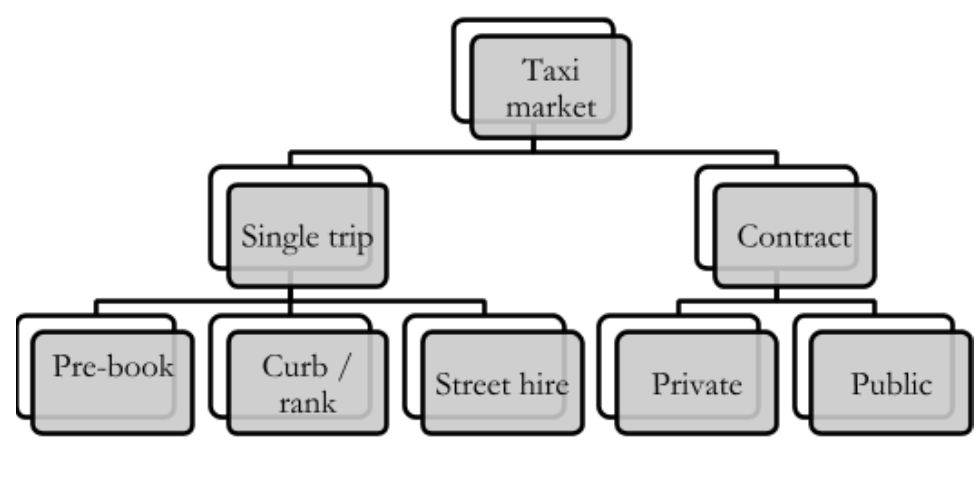
Figure 1. Taxi market